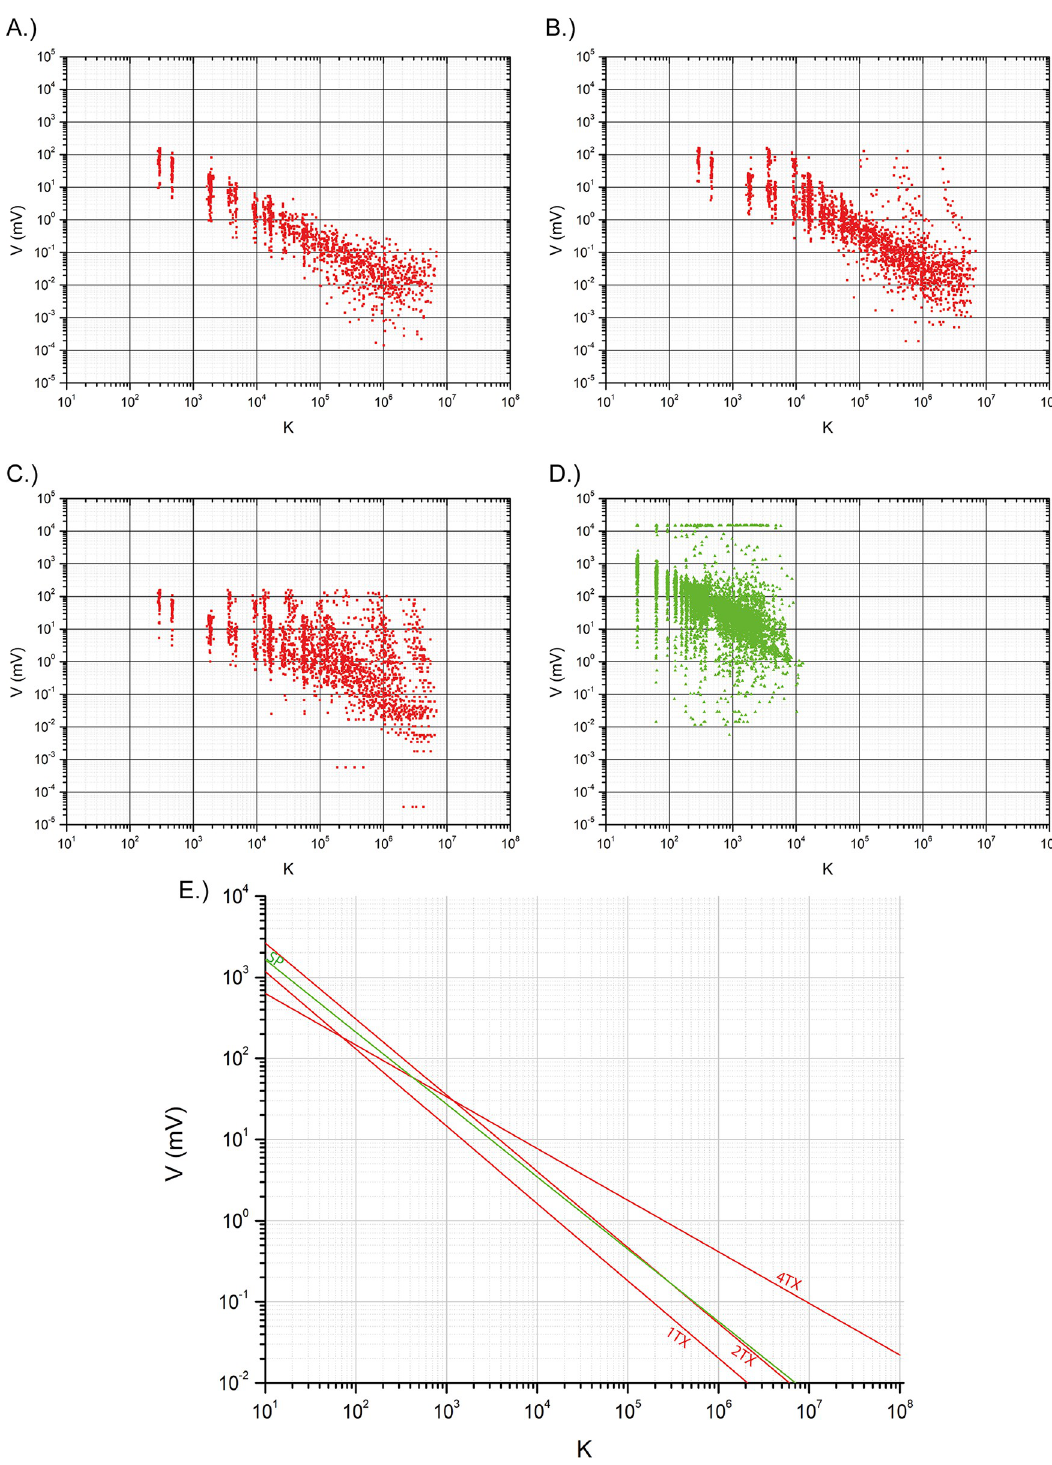
Fig 4. Comparison of recorded voltages (in mV) versus geometrical factor of the different datasets. (A) MSS-1TX; (B) MSS-2TX; (C) MSS-4TX; (D) SP; (E) regression functions for the different datasets.